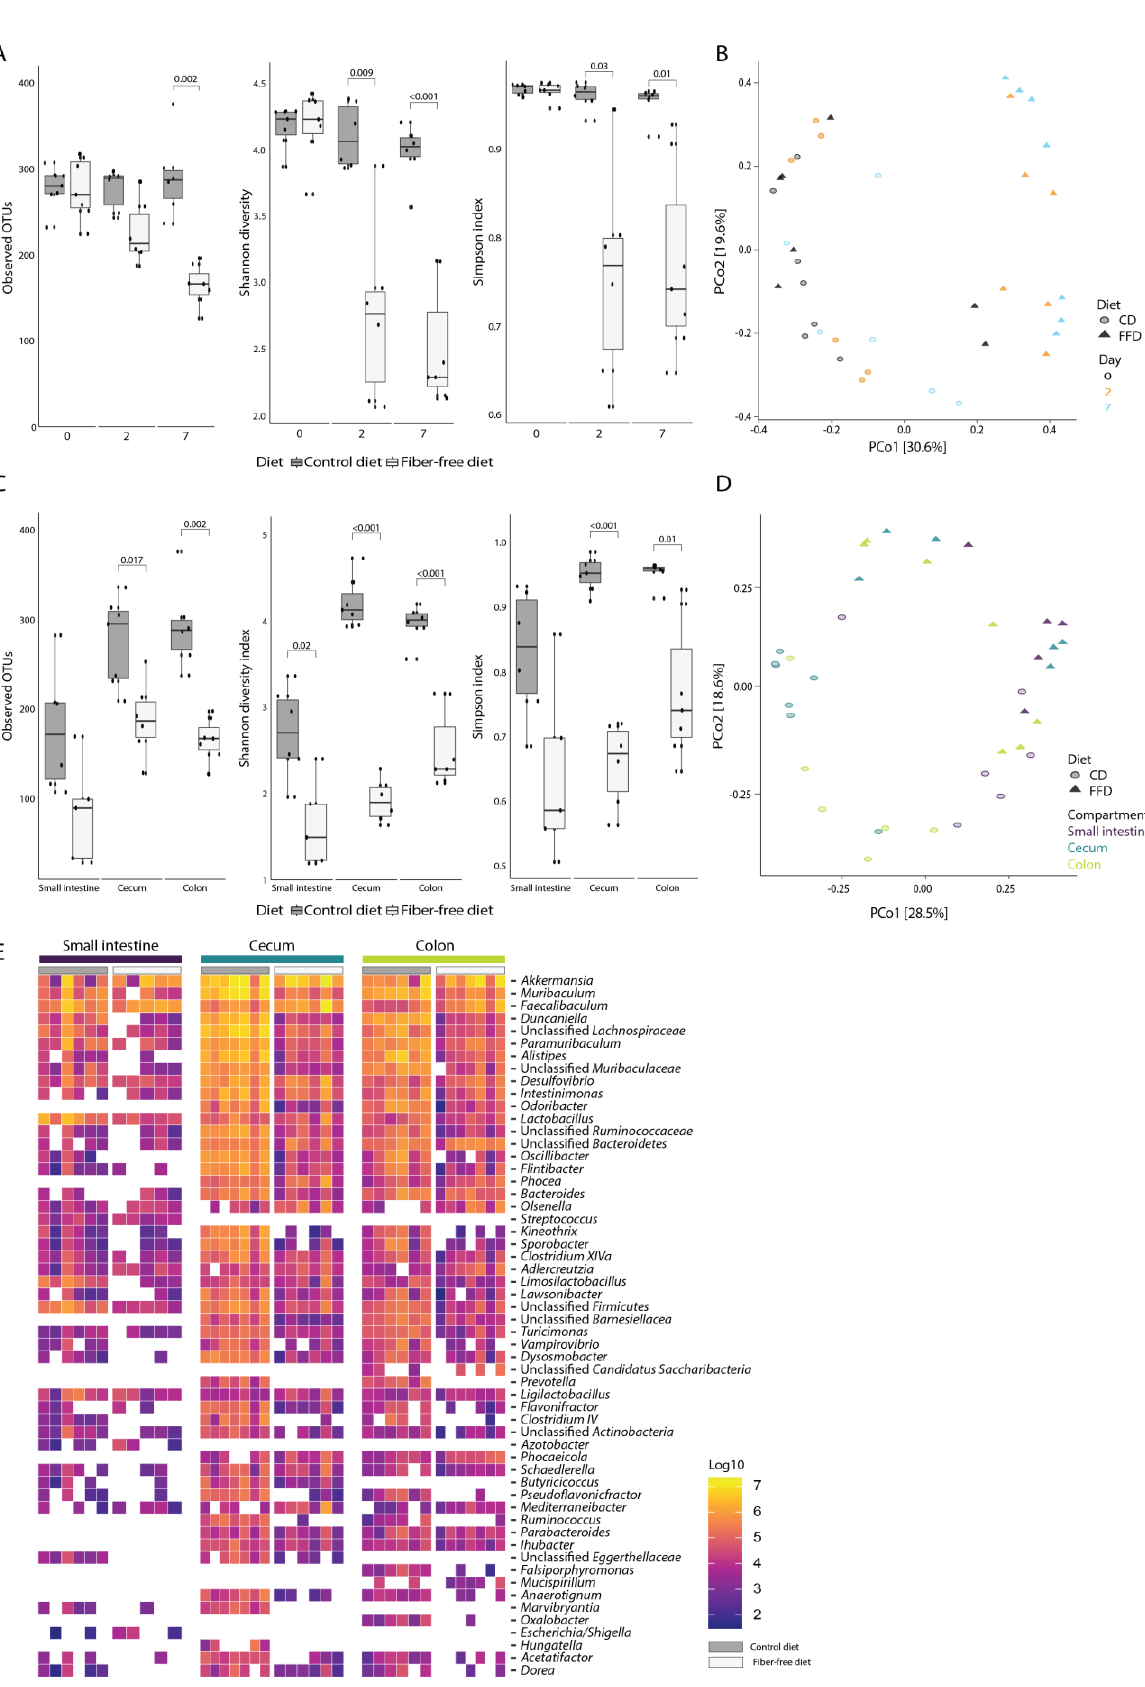
Figure 3. Dietary fiber deficiency decreases microbial alpha-diversity and is a key driver of microbial beta-diversity. Fecal samples were taken 0, 2, and 7 days after dietary intervention. ( A ) Fiber deficiency decreases bacterial richness and alpha diversity (ANOVA, p < 0.001 for all measures) in